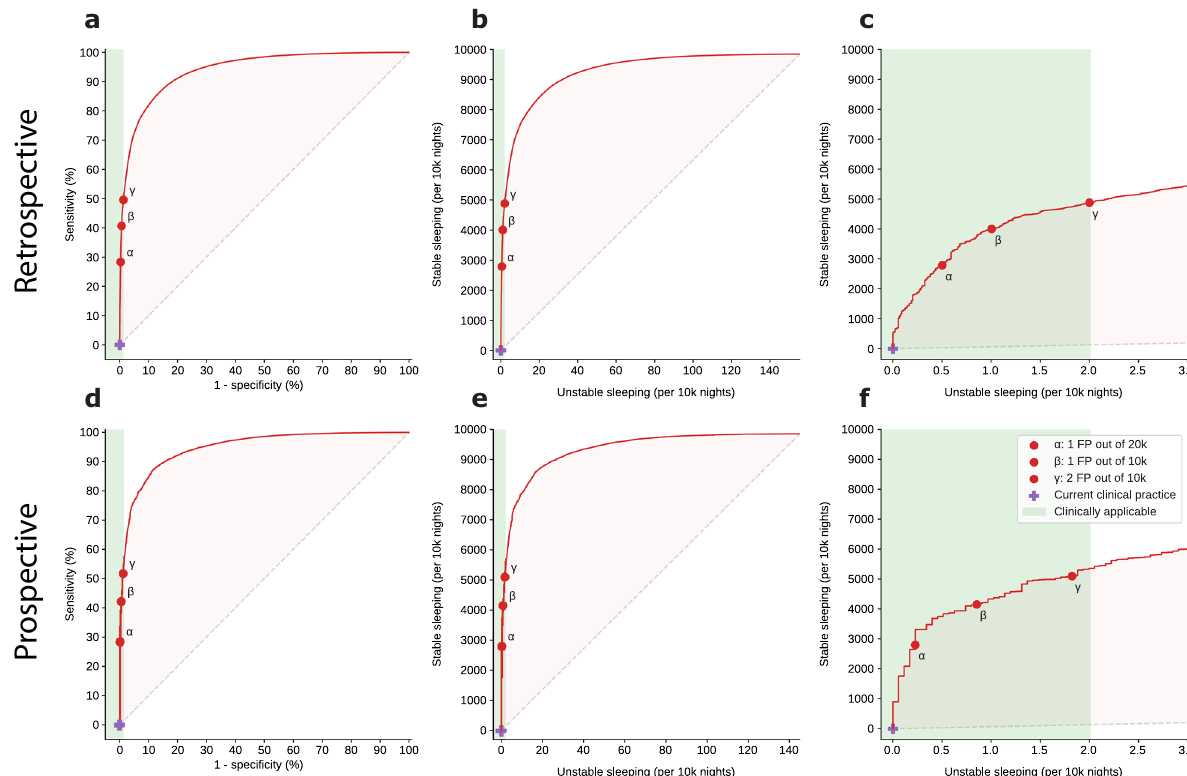
Fig. 3 Model performance illustrated by receiver operating characteristic (ROC) curves and clinically renormalized variants. ROC curves for predicting overnight stability on the retrospective test ( a ) and prospective ( b ) datasets. The clinically renormalized variants for retrospective ( b , c ) and prospective ( e , f ) datasets show the balance between correctly letting stable patients sleep ( Y -axis) and erroneously recommending sleep (predicted stable) to patients who ultimately had an elevated overnight risk score ( X -axis), normalized to 10,000 patient- nights. The zoomed-in panels ( c , f ) highlight the clinically applicable range, which minimizes the number of false-positive predictions. The red points on all the curves ( α , β , and γ ) represent three different clinically applicable model thresholds, which were chosen according to the number of false positives they yielded for the retrospective test set. For example, threshold γ , the least conservative, maintains the number of unstable sleeping nights at the edge of acceptability, at 2 out of 10,000 patient-nights, while allowing approximately half of all patients to sleep safely (5000 out of 10,000 patient-nights). The blue cross on the bottom left of all panels indicates current practice, where all patients are woken for vital sign monitoring regardless of the risk patients around the world, showing signi fi cant reductions in sleep can adjust the con fi dence threshold to implement a more quality for patients in North America 1,2,7 , Europe 17 , and Australia 18 , stringent or risk-averse solution. We evaluated a simple logistic regression model, receiving the among others. This sleep quality reduction has been linked to a same input variables as the proposed RNN, that uses the latest range of adverse health outcomes, including delirium; cardiac and instance of VS measured right before the predicted patient-night metabolic derangements; cognitive impairment, especially in rather than a sequence of VS. Although the linear model older adults 4,19 ; development of various pain conditions; elevation performed signi fi cantly worse on the task (random permutation of in fl ammatory markers; a decline in self-reported physical test of AUC ROC scores, p < 0.05), saving 7% less patient-nights, we health-status 20 ; weakened immunity; hypertension; elevated stress believe that such a model under data or computing power hormones; and increased mortality 3 . Importantly, many of these constraints can be employed with a high degree of success over the current clinical practice. Our fi ndings highlight the safety and accuracy of a machine sleep disruption can have an effect on the actual values of the learning-based solution to avoid unnecessary overnight VS overnight VS — causing erroneous risk alerts and unnecessary monitoring. The limited number of inputs needed also demon- interventions — as both blood pressure 21 and HR 22 are directly strates the feasibility of widely deploying such an approach, saving millions of sleepless patient-nights. We anticipate this directly improving patient outcomes and satisfaction; boosting health provider ef fi cacy by reducing fatigue; and enabling signi fi cant cost savings for health systems. Due to the large- scale data set, our model is robust to different healthcare sites, patient demographics, and conditions. VS assessments are the second most common cause of sleep disruption in the hospitalized patient 16 , and safely reducing these interventions overnight can improve patient sleep quality and quantity while leading to better health outcomes. Multiple studies have measured the quality and quantity of sleep in hospitalized